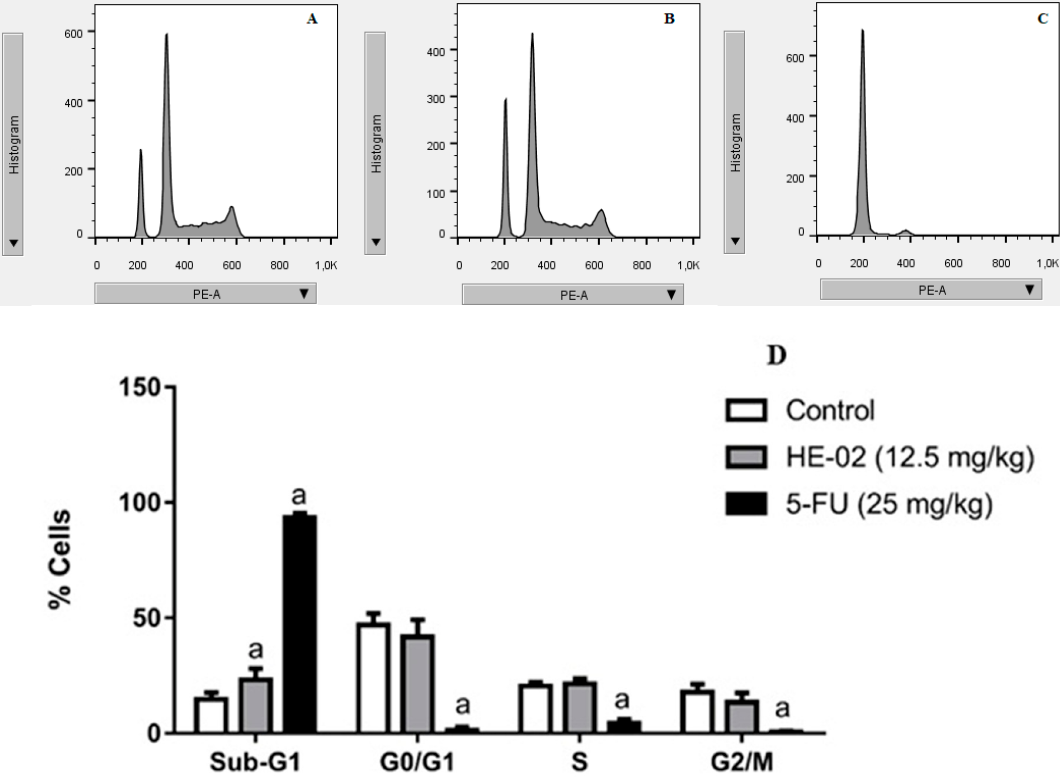
Figure 2. Effects of HE-02 and 5-FU on the cell cycle of Ehrlich ascites carcinoma cells. Representative histograms of ascites carcinoma cells in different phases of the cell cycle after treatment with: ( A ) 12% tween 80 (tumor control); ( B ) HE-02 (12.5 mg/kg); ( C ) 5-FU (25 mg/kg); ( D ) Percentage of Ehrlich ascites carcinoma cells in phases of cell cycle after different treatments. Data presented as mean ± SEM of six animals analyzed by ANOVA followed by Tukey test. a p < 0.05 compared to the tumor control group.